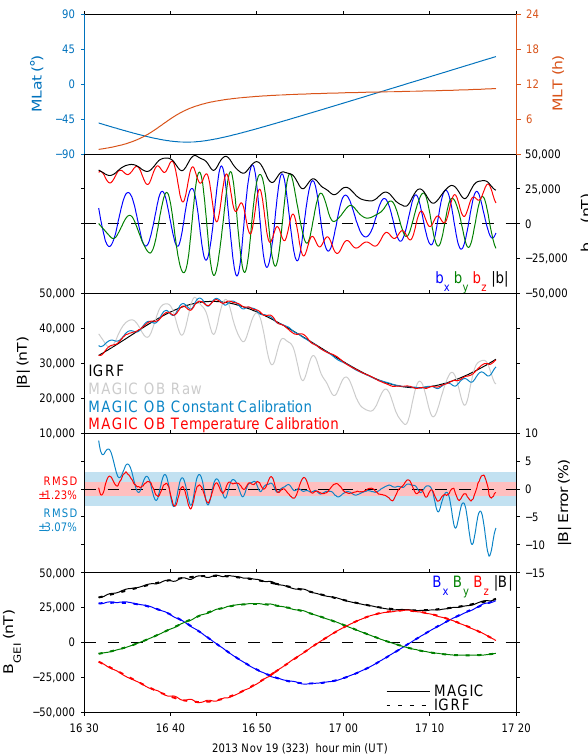
Figure 3. Science mode data from the outboard MAGIC sensors in the same format as Fig. 2. In the third and fourth panels, the red lines correspond to the temperature-dependent